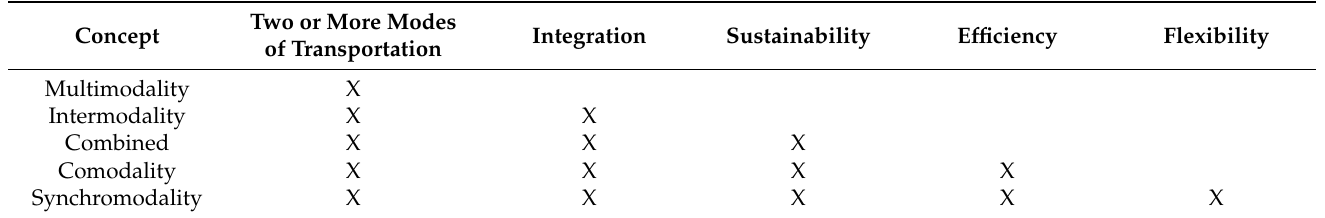
Table 1. Comparison between synchromodality and legacy modal shift paradigms based on such core capabilities as integration, sustainability, efficiency, and flexibility. Adapted from